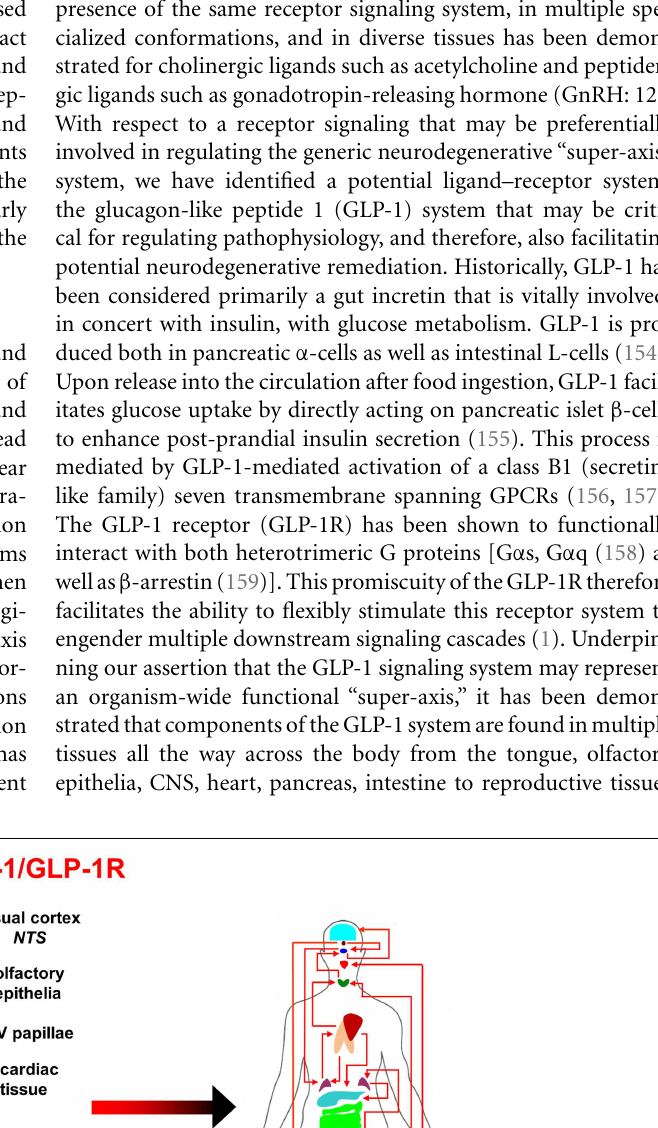
FIGURE 1 | Glucagon-like peptide 1 (GLP-1) ligand and receptor system super-axis are shown .The expression of the ligand and receptor components of the GLP-1 system spans the whole human body.The repetitive expression of this GPCR system in multiple tissue types reinforces the importance of maintaining energy balance across the whole organism